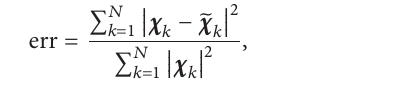
and err = 2 and err = 6%): (f) real and (g) imaginary 2